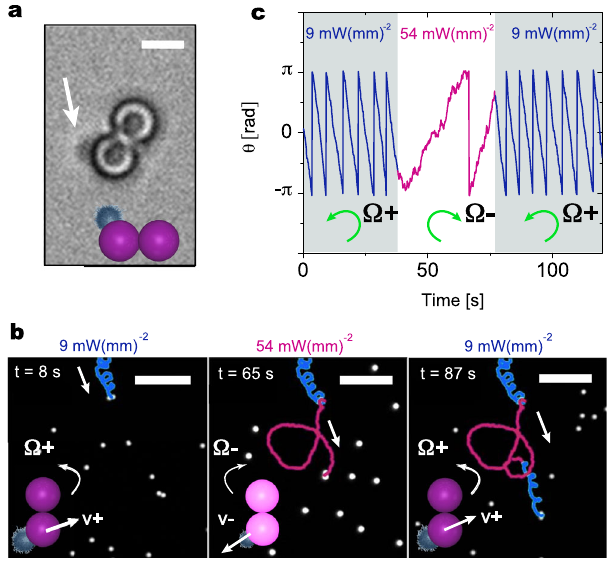
Fig. 6 Motion chirality control with L-shaped particles. a Optical microscopy image of an L-shaped recon fi gurable cluster comprising two PS particles and one microgel in MilliQ water at room temperature. The arrow indicates the microgel position b Trajectories of an L-shaped particle at two different levels of fl uorescence light power density ( ρ FL = 9mW(mm) − 2 – blue; ρ = 54mW(mm) − 2 – magenta). The schematics in the insets show the FL propulsion direction relative to the PS-microgel combination as a function of ρ FL and the corresponding angular velocity Ω . Upon changing illumination density, the helical trajectory changes chirality, due to propulsion reversal, and pitch, due to shape recon fi guration. Scale bars: 5 μ m. c Orientation angle as a function of time for a self-propelling L-shaped particle at different light illumination levels. Upon tuning ρ FL up, the rotation changes direction and slows down. The change is fully reversible upon reducing the fl uorescent